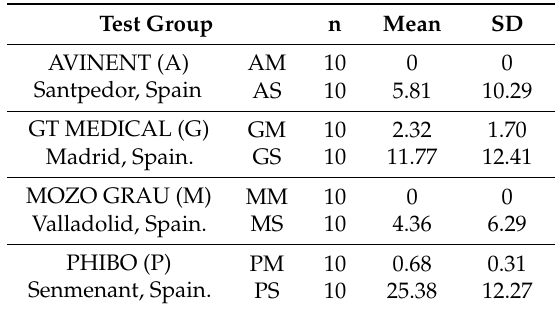
Table 2. Means and standard deviations (SD) misfit values (micrometers) for implant system and